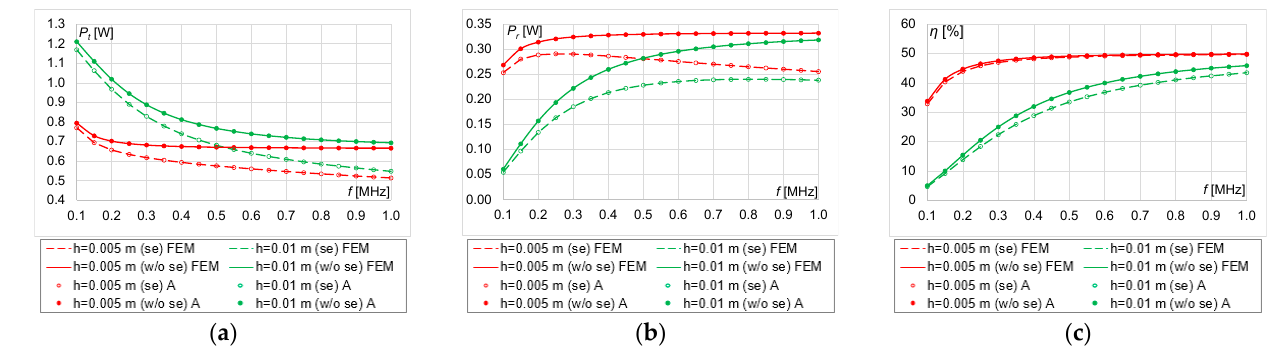
Figure 18. Results for n = 20 for the cases with and without skin effect: ( a ) P t , ( b ) P r , ( c ) η .